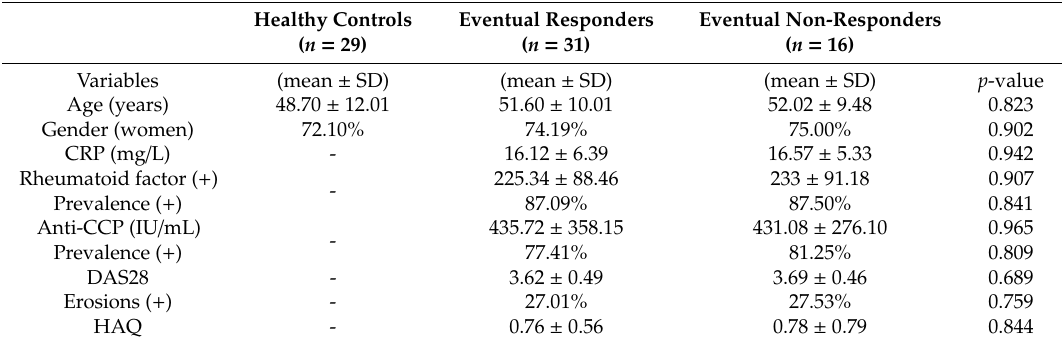
Table 1. Patient demographics and clinical and biological characteristics at